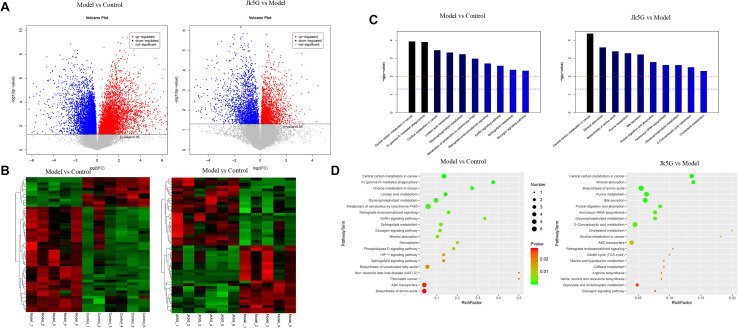
Different metabolites in serum on the model versus control groups, and the microecological preparation (JK5G) versus model groups. Volcano plot of different metabolites in the model versus control groups, and the JK5G versus model groups (A), heat map clustering of different metabolites in the model versus control groups, and the JK5G versus model groups (B), enrichment pathways of differential metabolites (C,D).